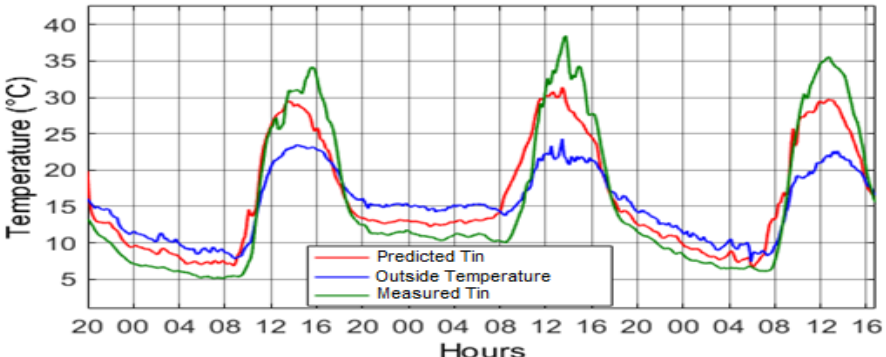
Figure 5. Measured and simulated data of the temperature inside the greenhouse.